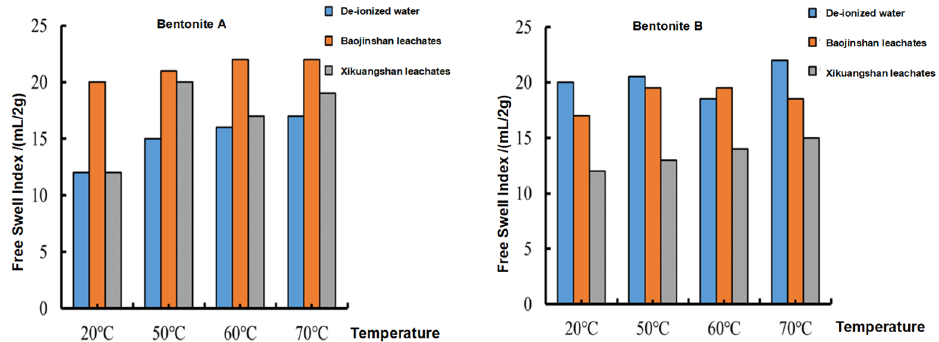
Figure 3. Free swell index of bentonite A and B at different temperatures.